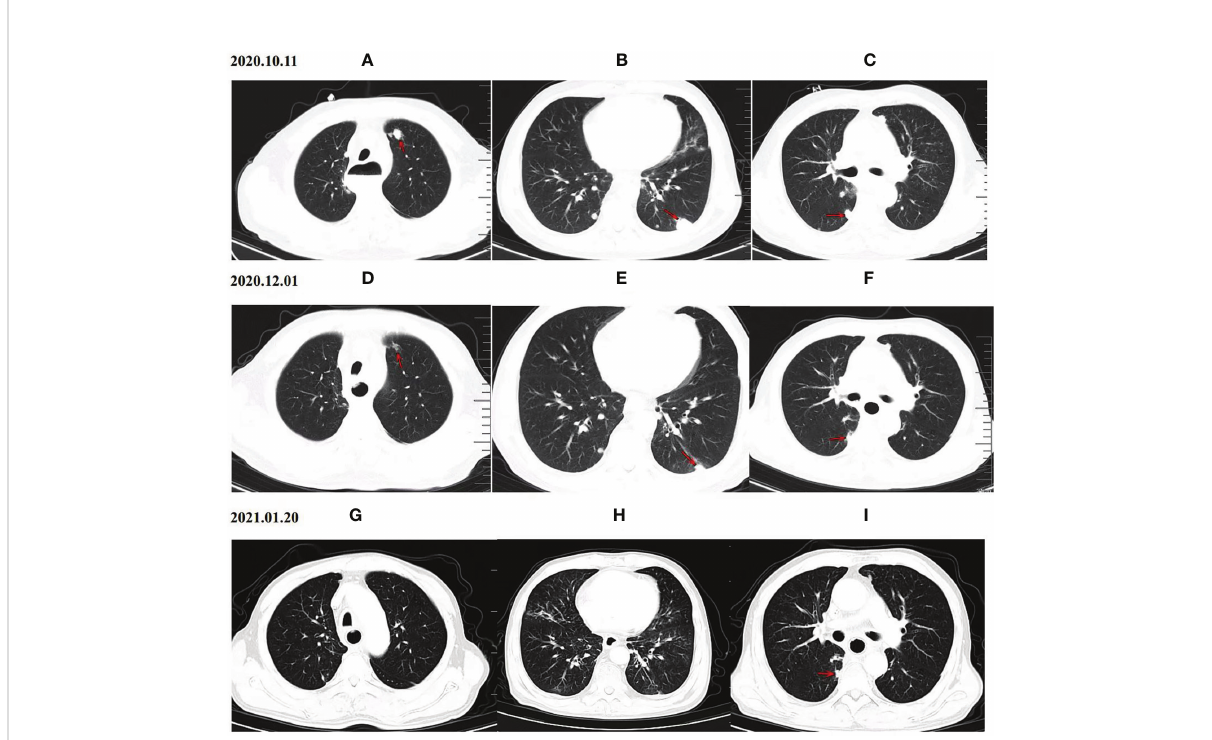
FIGURE 4 CT scan results of the changes for target lesions in one patient with esophageal squamous cell carcinoma before and after anlotinib combined with PD-1 blockade administration. Upper panel (A – C) CT scan of the patient ’ s lung before the treatment (October 11th, 2020), Middle panel (D – F) CT scan of the patient ’ s lung after 2 cycles of treatment with anlotinib plus PD-1 blockade (December 1th, 2020), PR was achieved after 2 cycles of treatment. Lower panel (G – I) Chest CT images after 4 cycles of treatment with anlotinib plus PD-1 blockade (January 20th, 2021),